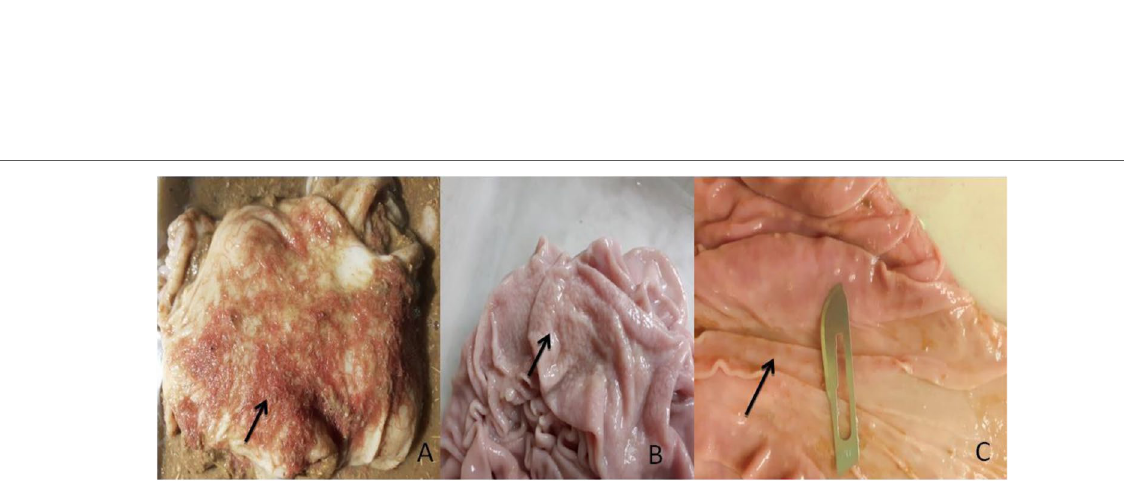
Fig. 7 Abomasum of goat infected with 10,000 L3 of H. controtus: (A) large number of adult worms; (B) thickened and rough mucosal folds (arrow), (C) nodular lesion (blade) and petechial haemorrhages (arrow) in the fundic